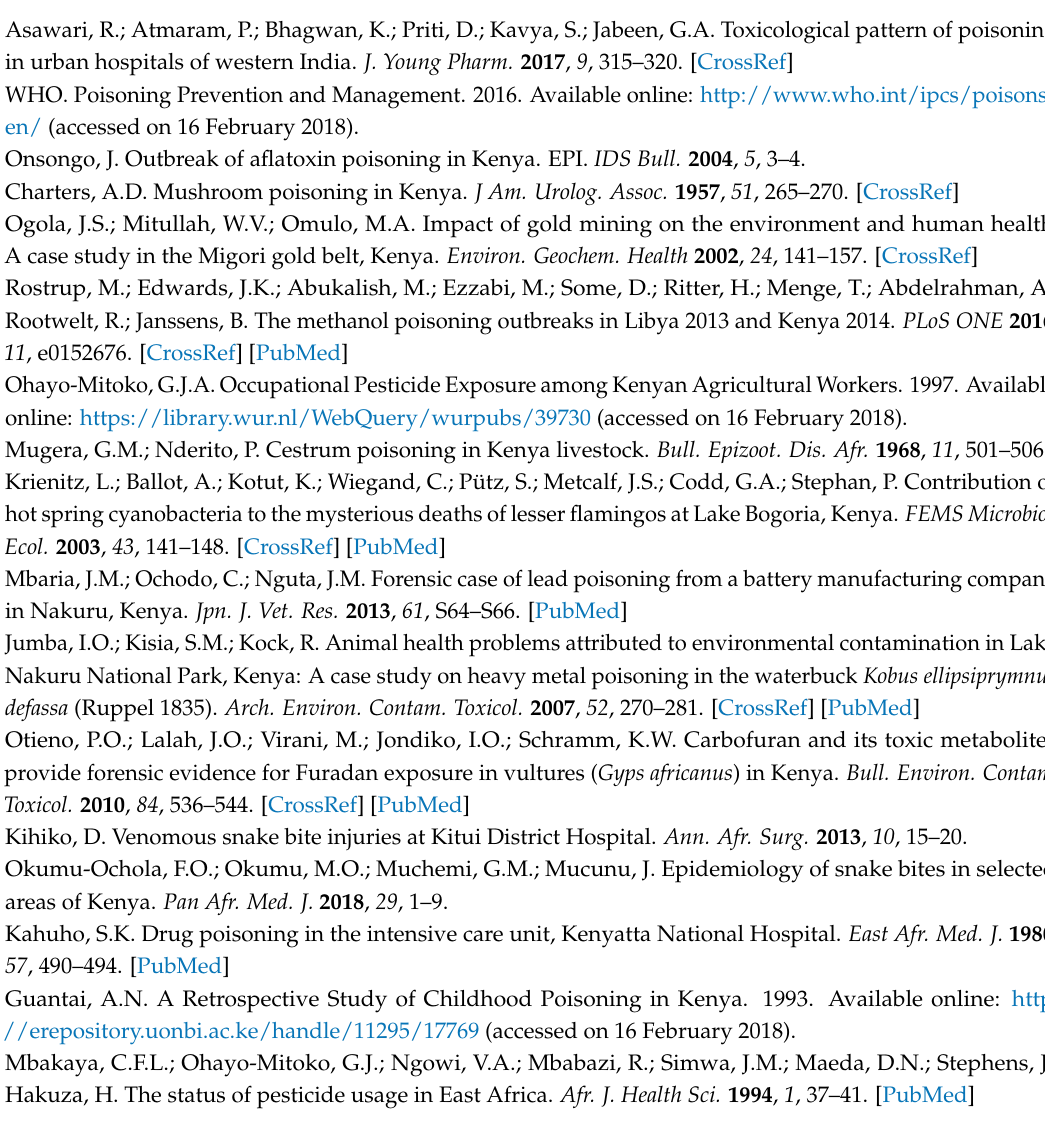
Figure S1: Ethical Approval Form; Table S2: Reasons for deliberate poisoning and distribution of victims based on gender and age; Table S3: Multivariate analysis of poisoning exposure factors and the survival of victims who presented to JOOTRH during the study